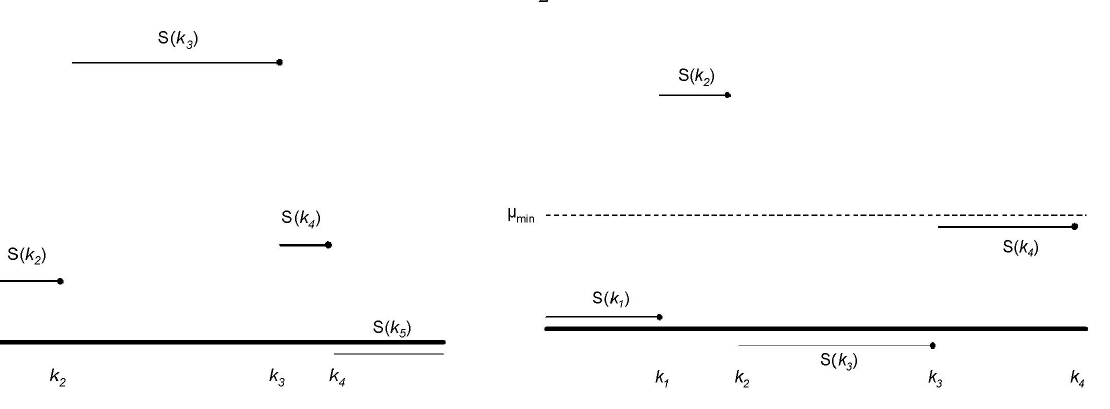
Figure 2. Illustration of situation where removed jump does not have smallest value of d . As illustrated, we would remove the probe at k 2 rather than the probe at k 1 , and then the probe at k 4 rather than the probe at k 3 even though d 1 v d 2 and d 3 v d 4 The solid horizontal line corresponds to a log-intensity ratio of 0.